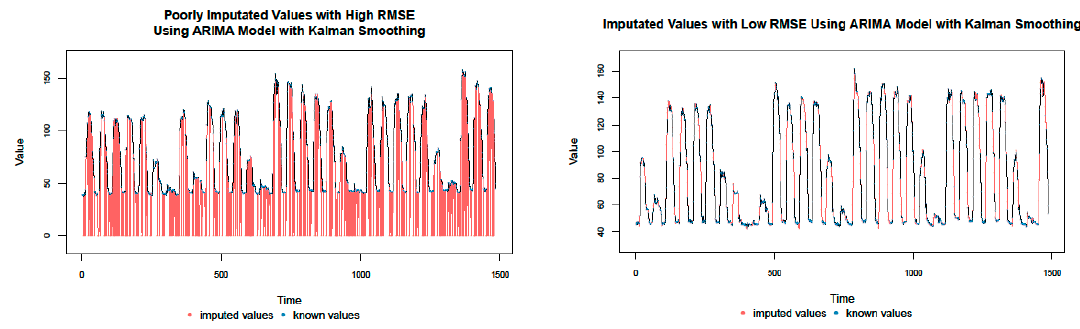
Figure 8. Outliers and correctly imputed data using ARIMA